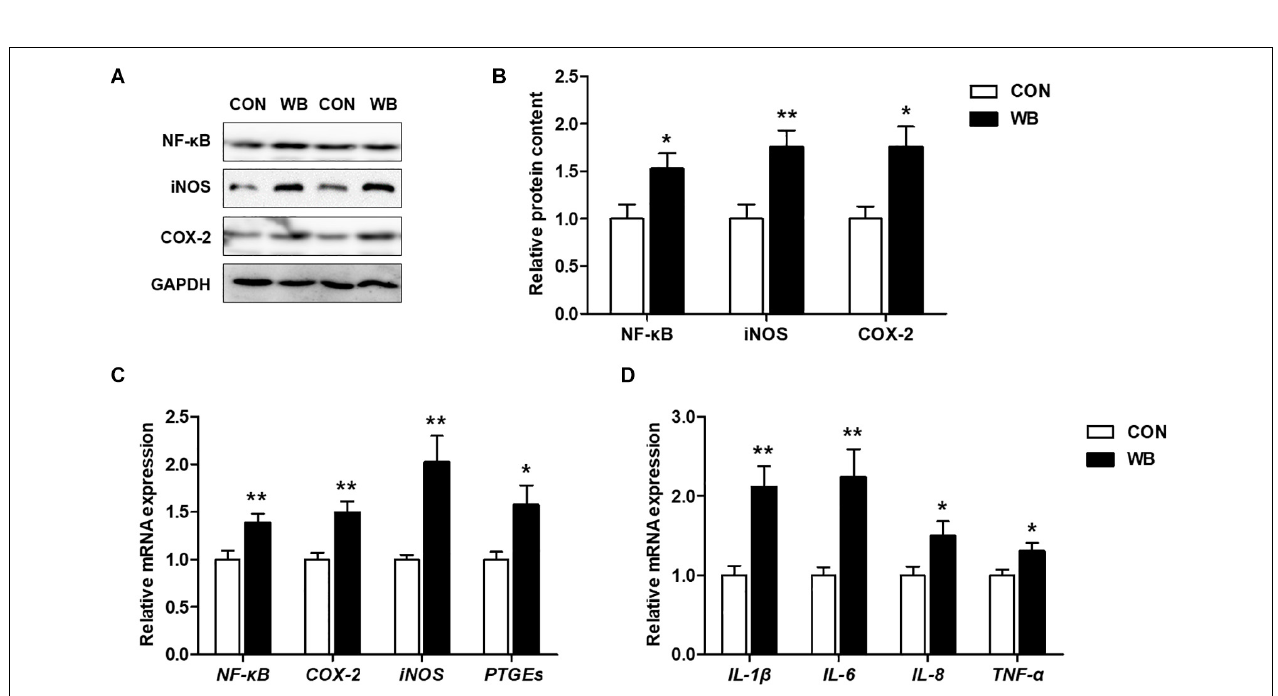
FIGURE 4 | Inflammatory mediators and proinflammatory cytokines in the liver tissues of broiler chickens with normal (CON) and wooden breast (WB) pectoralis major muscle. (A) Representative Western blotting images of nuclear factor kappa-light-chain-enhancer of activated B cells (NF- κ B), inducible nitric oxide synthase (iNOS), and cyclooxygenase-2 (COX-2). (B) Relative protein content of NF- κ B, iNOS, and COX-2. (C) Relative mRNA expression of NF- κ B, iNOS, COX-2, and prostaglandin E synthetases (PTGEs). (D) Relative mRNA expression of pro-inflammatory cytokines including interleukin (IL)-1 β , IL-6, IL-8, and tumor necrosis factor (TNF)- α . Data are expressed as the mean ± SE ( n = 10). ** P < 0.01 and * P < 0.05.